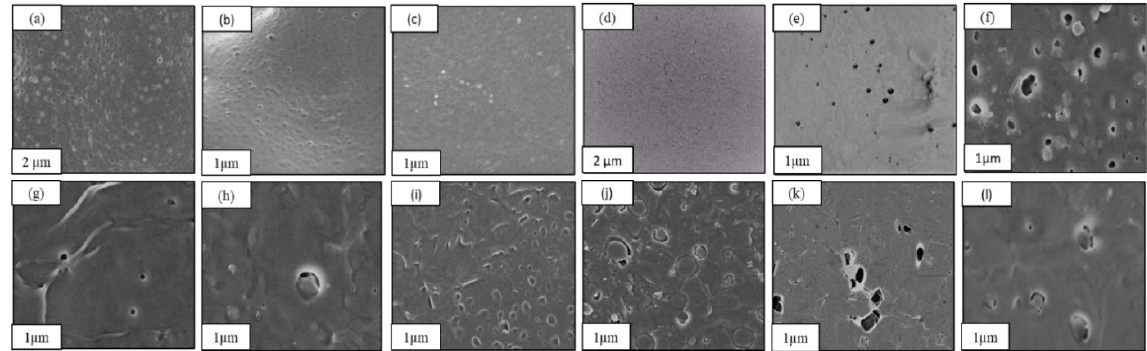
Figure 1. Scanning electron microscopy (SEM) of the macro and micro pores in porous PLA films with different PEO and NaCl percentages. ( a ) PL-N50 ( b ) PL-N70 ( c ) PL-N100 ( d ) PL-PO ( e ) PL-N ( f ) PL-PC2-N50 ( g ) PL-PC3-N50 ( h ) PL-PC4-N50 ( i ) Neat PCL/PLA (4:1) ( j ) PL-PC4-N50 ( k ) PL-PC4-N70 ( l ) PL-PC4-N100.